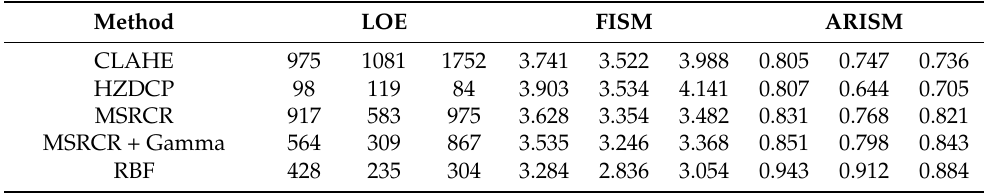
Table 6. Results of light enhancement metrics for each